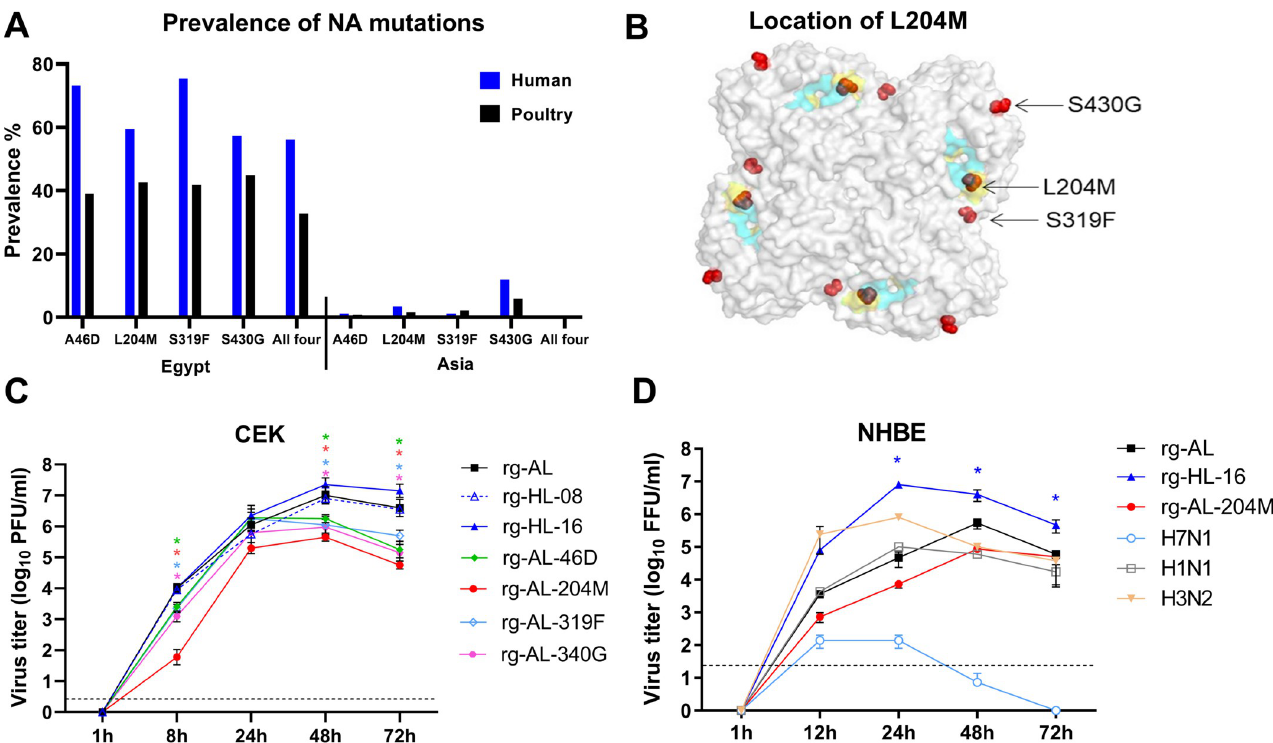
Fig 1. Prevalence of NA mutations in H5N1 of human and poultry-origin, structural modelling and replication in primary avian and human cell culture. Prevalence of N1-NA mutations in human (blue) and poultry (black) origin sequences of H5N1 in Egypt and Asia in GenBank and GISAID at 31.12.2016 were retrieved and analyzed using Geneious (A). Predicted location of NA mutations (depicted in red) on the NA tetramer generated by SWISS Model using the amino acid sequence of A/chicken/Egypt/06207/2006 (accession number ACR56180); one of the earliest viruses introduced into Egypt in February 2006. Functional sialidase residues R98, D131, R132, R205, E257, R273, R348 and Y382 (N1 numbering) are in cyan and framework sites E99, R136, W159, S160, D179, I203, E208, H255, E258 and E405 are in yellow. A46D is located in the stalk domain and is not visible in this model (B). Virus replication assays in primary chicken embryo kidney cells (CEK) (C) and primary normal human bronchial epithelial cells (NHBE) (D) infected at an MOI of 0.001 for indicated time points were done in three independent replicates. Results are shown as mean and standard deviation. Asterisks refer to statistical significance compared to rg-AL at p < 0.05 (see main text for details). Dashed lines in panels C and D indicate the predicted detection limit of plaque and foci assays in this study.